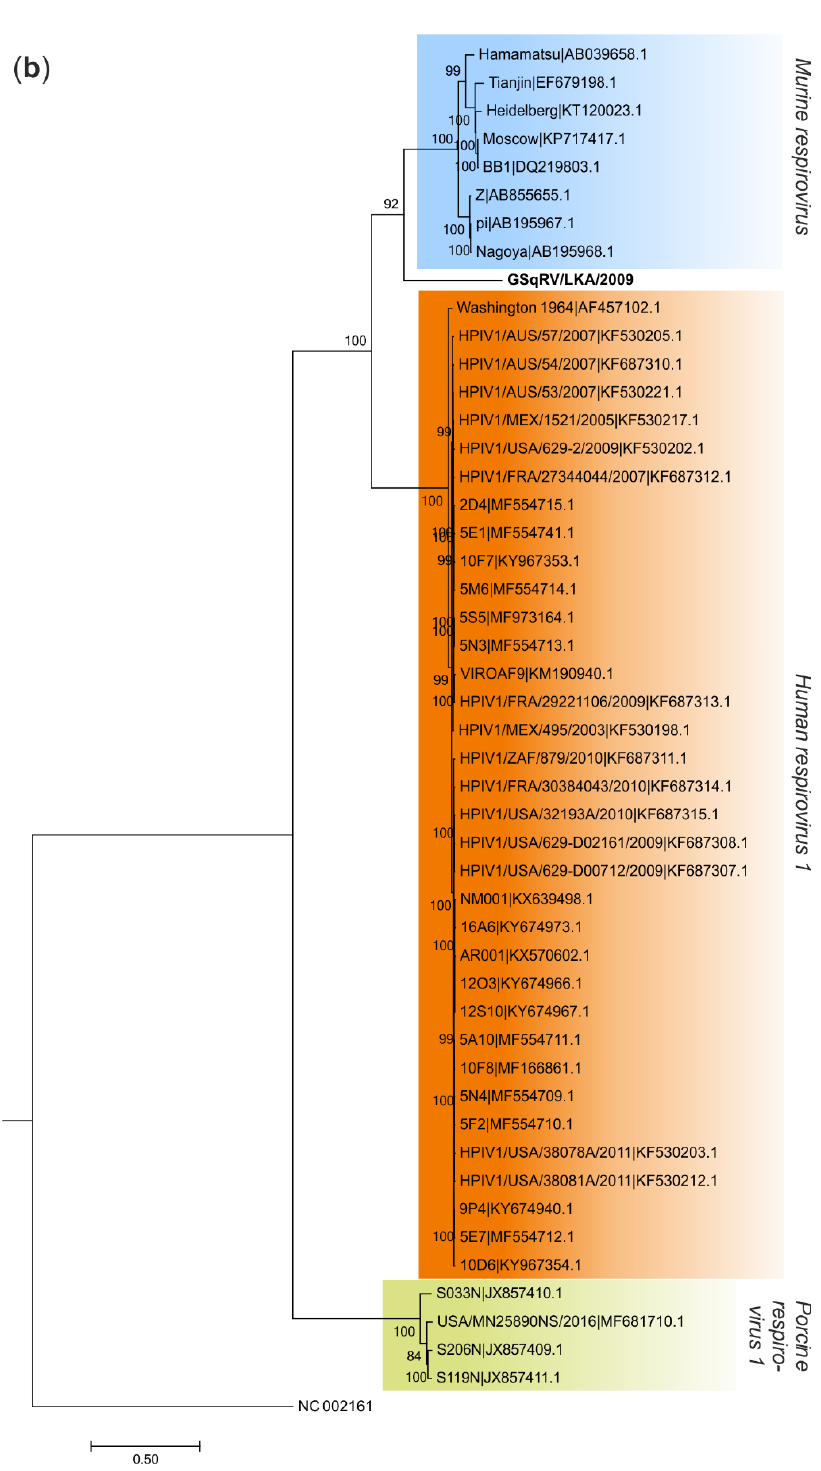
Figure 5. Classification of GSqRV in the genus Respirovirus by phylogenetic analysis of selected representatives of each species with the main host depicted in black silhouettes ( a ) and phylogenetic analysis of murine, human, and porcine respirovirus 1 with bovine respirovirus 3 (NC002161) included as outgroup ( b ). Selected were available complete genome sequences within the species excluding clones and revertants. Sequences were aligned with MAFFT and phylogenetically analyzed using RAxML with the model GTR GAMMA and 1000 replicates for bootstrap support. Annotation includes strain/isolate and accession number.